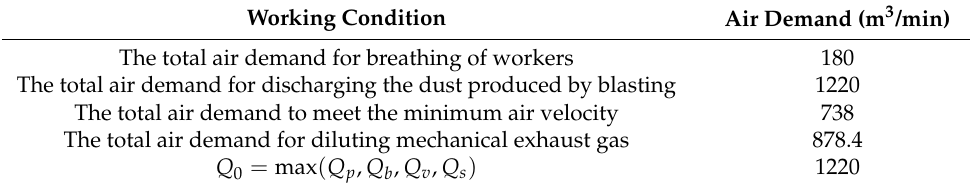
Table 1. Air demand in the theoretical calculations.